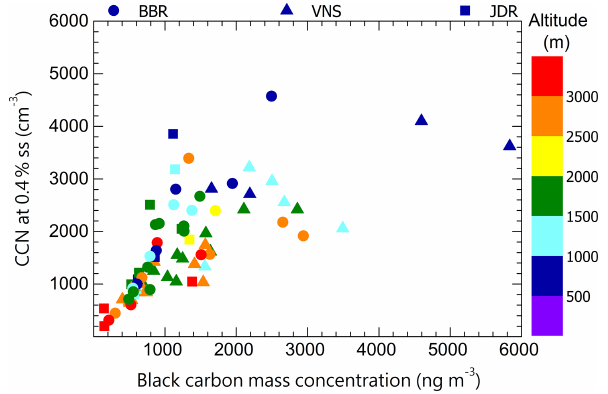
Figure 5. Association of CCN number concentration at 0.4% su- persaturation with BC mass concentration over the eastern (BBR; circle), central (VNS; triangle) and western (JDR; square) IGP re- gions. Colour codes indicate the altitude of